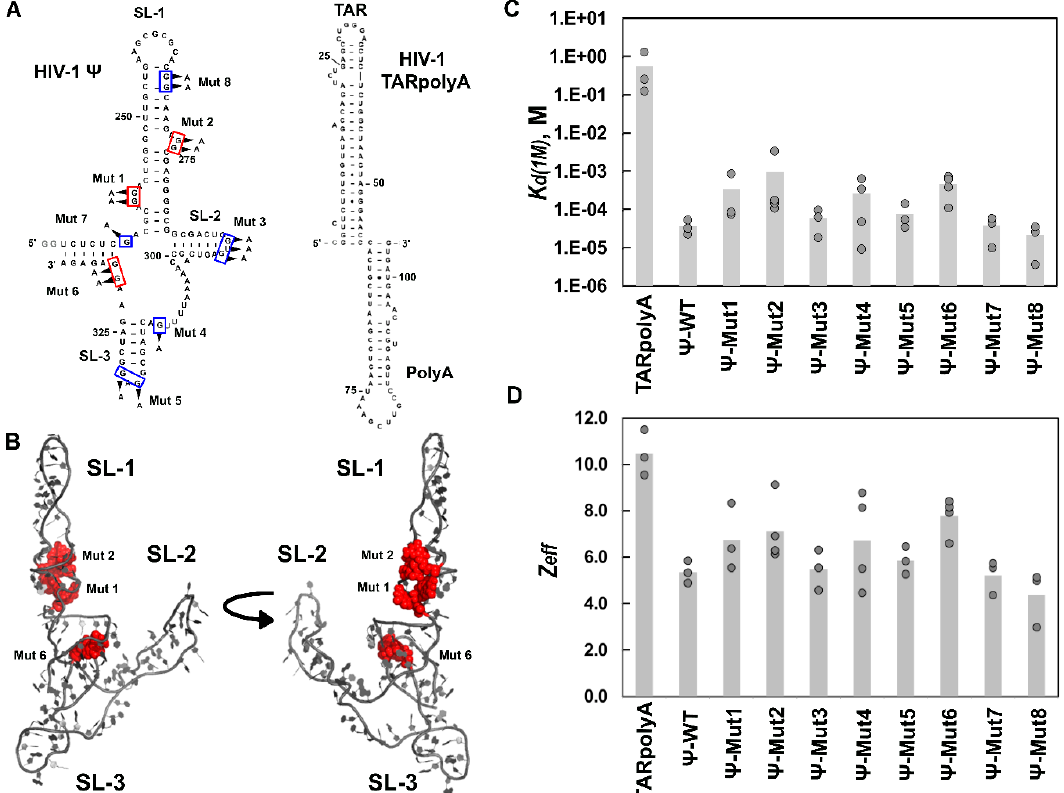
Figure 5. HIV ‐ 1 RNA constructs used in this work and salt ‐ titration binding results with HIV ‐ 1 Gag ∆ p6. ( A ) Predicted secondary structures of HIV ‐ 1 Ψ ( left ) and HIV ‐ 1 TARpolyA ( right ) are shown. Eight mutant Ψ RNAs are indicated by the boxed nt and arrows (Mut1 ‐ Mut8). Additional 5’ G nt not present in the HIV ‐ 1 genome were added to facilitate in vitro transcription and are shown in gray; ( B ) The location of Mut 1, 2, and 6 mapped onto the all ‐ atom model of HIV ‐ 1 Ψ previously determined from small angle x ‐ ray scattering data and computational modeling [61]. Colors in A and B indicate mutations that had no effect on specificity (blue), and significant effects (red) based on salt ‐ titration binding assays. Bar graphs of K d(1M) values ( C ) and Z eff values ( D ) determined from salt ‐ titration assays with HIV ‐ 1 Gag ∆ p6 and HIV ‐ 1 TARpolyA, Ψ RNA, and Ψ RNA mutants. Values of three or four trials performed in each case are shown with the height of the bar indicating the mean value.